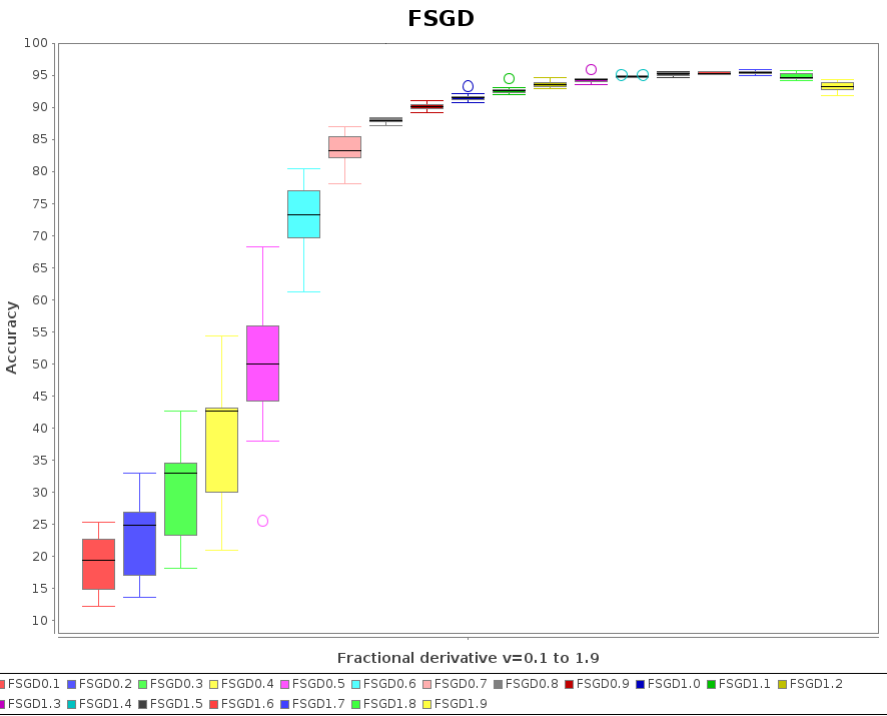
Figure 1. Experiment 1.1: Boxplots for accuracies of FSGD with 10-cross folding and ν = 0.1, 0.2, . . .,